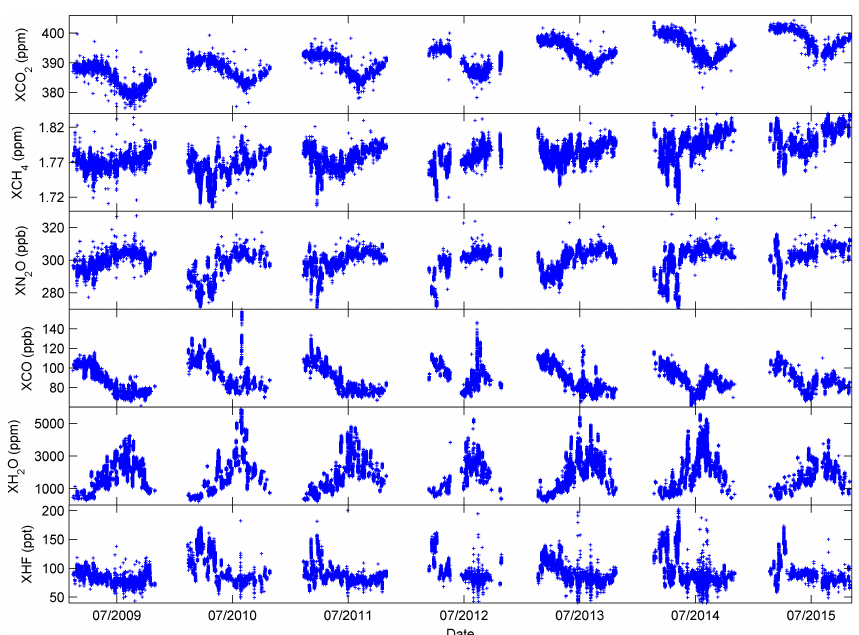
Figure 5. Time series of XCO 2 measurements at Sodankylä since 2009 (upper panel). Each marker indicates a single measurement. Lower panels correspond to other gases retrieved from the same measurements.